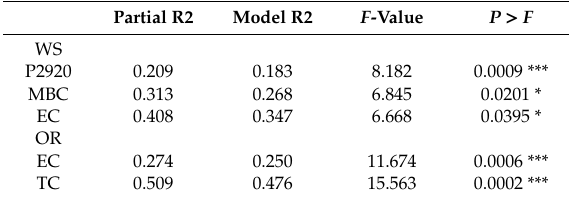
Figure S1: The evolution of soil moisture ( a ), electrical conductivity ( b ) and soil temperature ( c ) (mean and ± standard error) in each of four treatment conditions: soil only (Control), soil mixed with oilseed rape residues (OR), soil mixed with rye residues (Rye), soil mixed with wheat straw (WS), over a 105-day incubation period. Stars indicate significant di ff erences between treatments within the same day according to one-way ANOVA (* p < 0.05, ** p < 0.01, and *** p < 0.001), Figure S2: FT-IR spectra of the crop residues incorporated in the